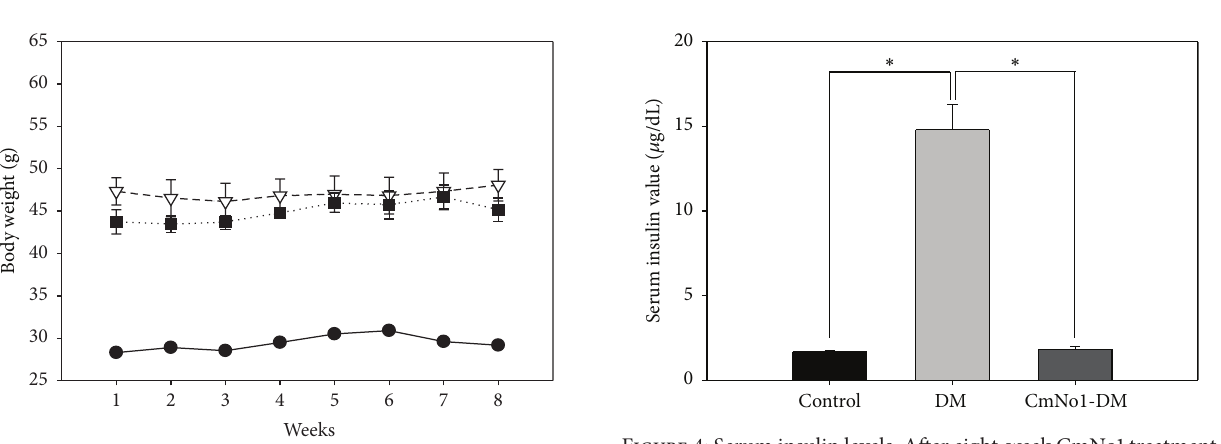
Figure 4: Serum insulin levels. After eight-week CmNo1 treatment, blood was drawn from overnight-fasted mice, and serum was analyzed by ELISA for insulin levels compared to control and DM mice. Data is expressed as the means ± SEM ( 𝑛 = 6 /group). Symbols specify significant difference from DM with ∗ indicating 𝑝 < 0.05